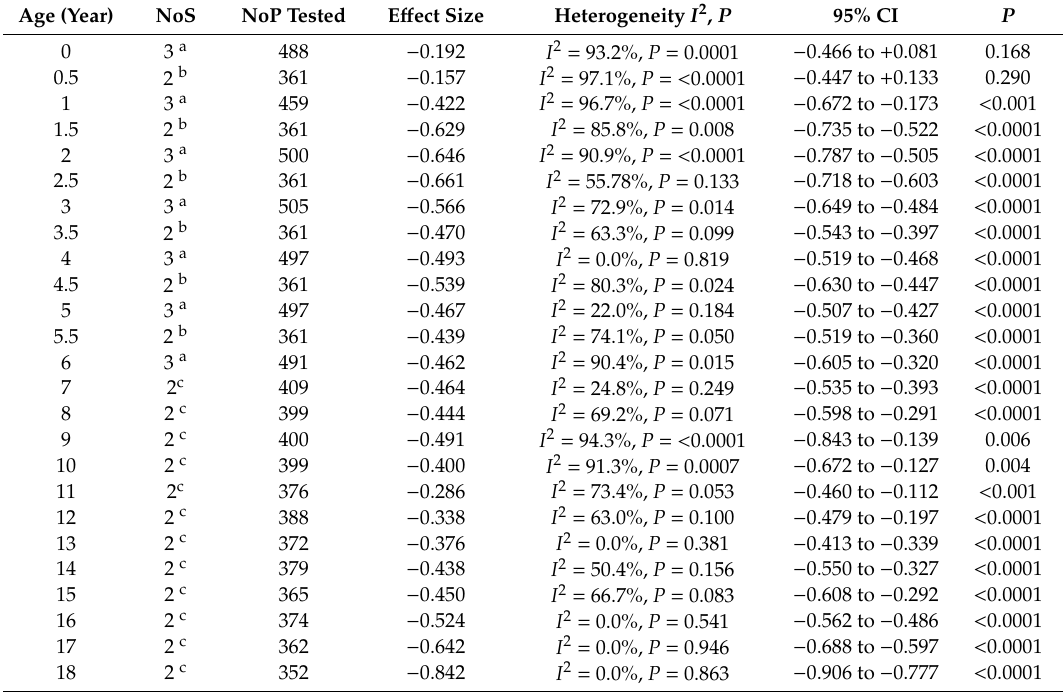
Table 5. Meta-analyses of height-for-age z-scores in children with